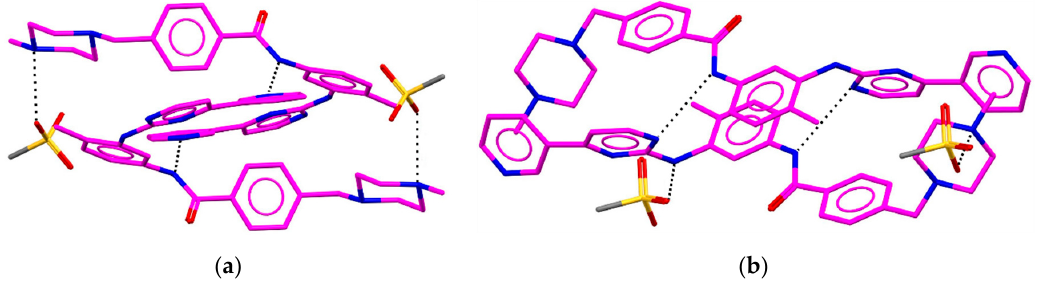
Figure 3. Fragment of H ‐ bonded motifs in crystals of ( a ) (HIma)(O 3 SCH 3 ) ∙ MeOH ∙ H 2 O, CSD code XEJLUW [32] and ( b ) α‐ form of (HIma)(O 3 SCH 3 ), CSD code XAVTOF [31] . H ‐ bonds are dotted. Hydrogen atoms are omitted for clarity.